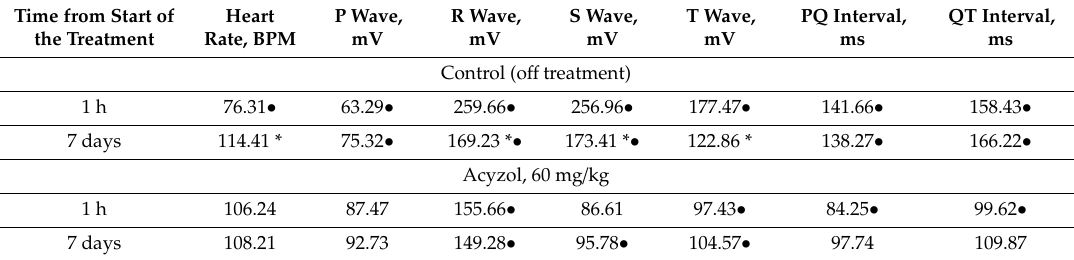
Table 3. Heart rate and electrocardiogram measurements of rats during the treatment of myocardial infarction with Acyzol, % of